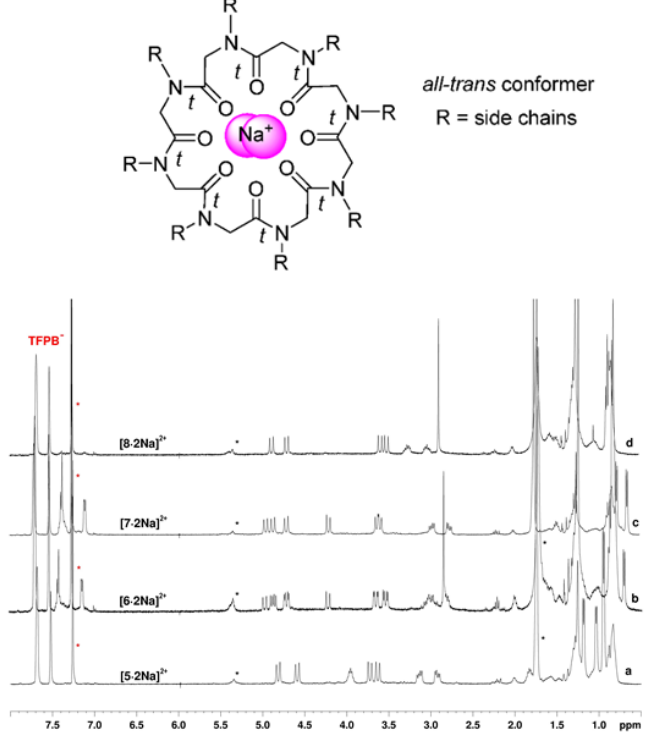
Figure 6. 1 H NMR spectra showing [ 5 – 8 2Na] 2+ complexes and general structure of the highly symmetric all-trans core conformer. Residual solvent peaks are labelled with a red asterisk. H 2 O and further CDCl 3 impurities are labelled with a black asterisk. 1.0 mM host solutions in the presence of 2.0 equivalents of NaTFPB in CDCl 3 (400